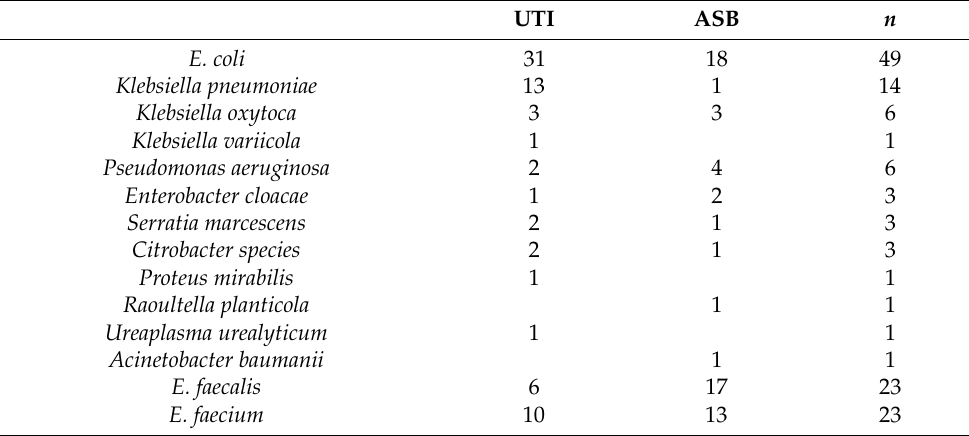
Table 2. Bacterial isolates from urinary samples of Kidney Transplant